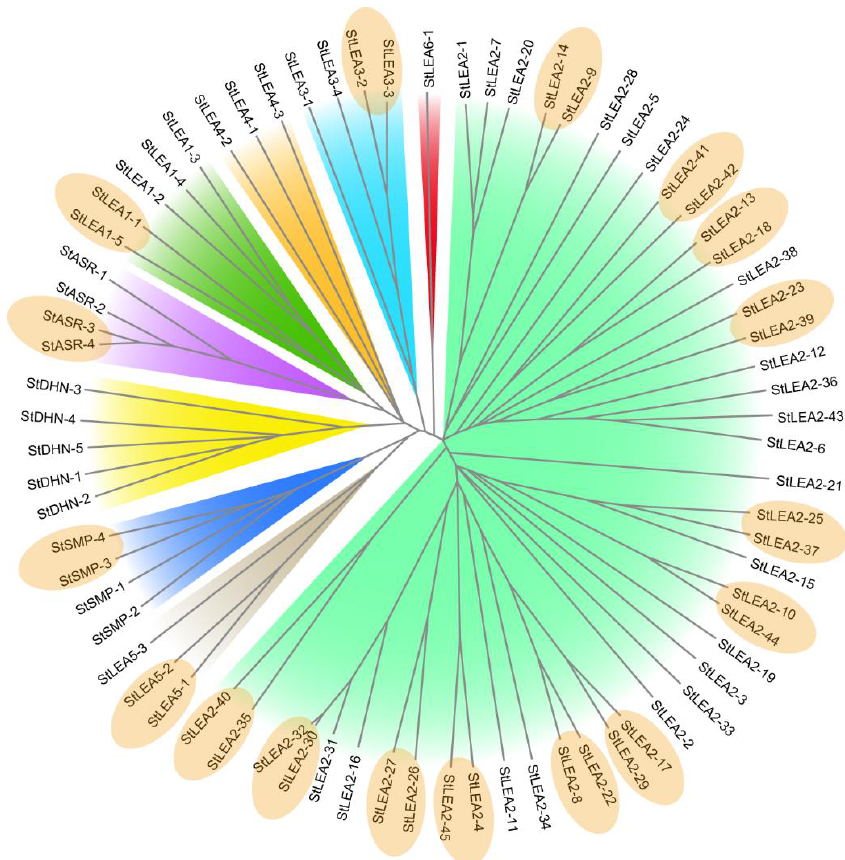
Figure 1. Phylogenetic analysis of potato late embryogenesis-abundant (LEA) proteins. The evolutionary tree of LEA proteins was constructed using MEGA X software [29], with ClustalW alignment, the neighbour-joining method, the bootstrap method, and 1000 repetitions. The LEA1, LEA2, LEA3, LEA4, LEA5, LEA6 ASR, DHN, and seed maturation protein (SMP) subgroups are presented in green, light green, light blue, orange, grey, red, purple, yellow, and blue, respectively. The sister pairs are circled using the same ellipses.